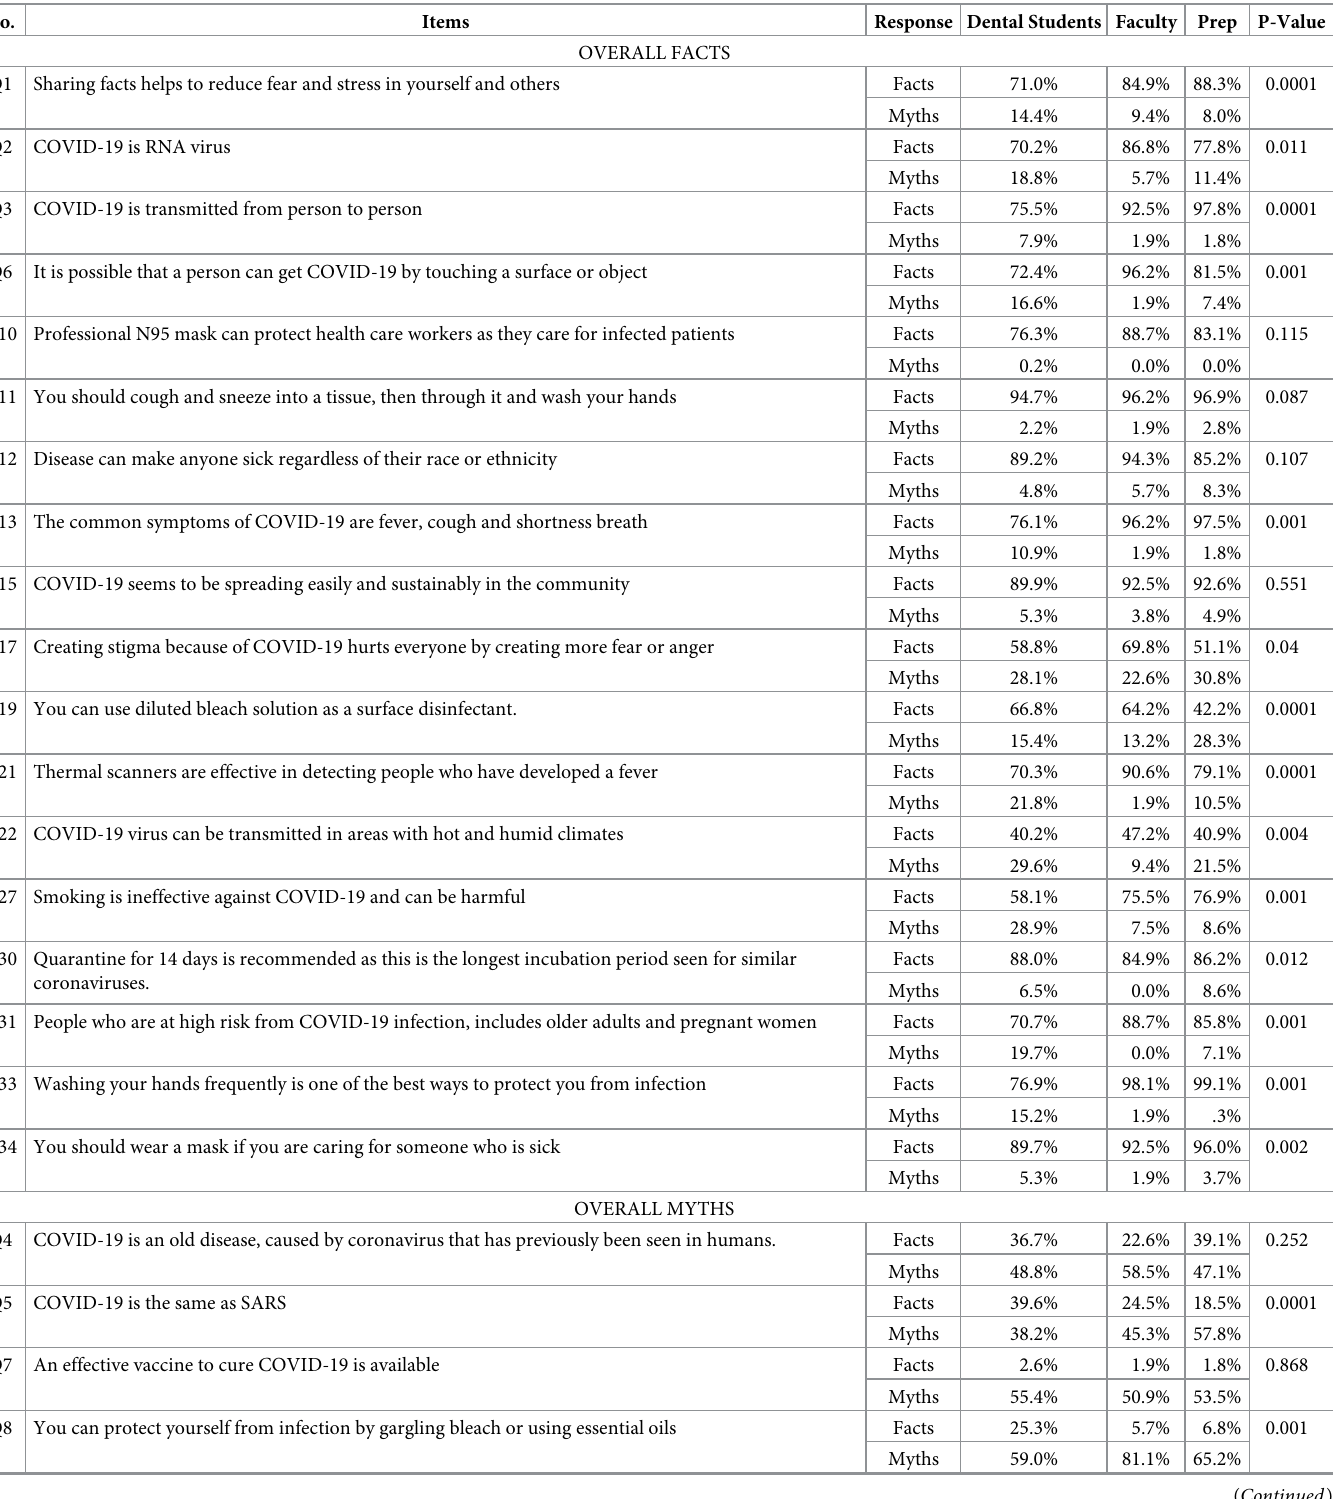
Table 2. Overall item wise comparison of fact and myth between faculty members, dental students and preparatory year students.